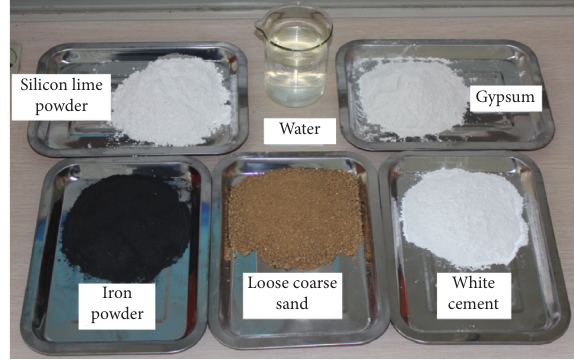
Figure 3: Composition of the similar